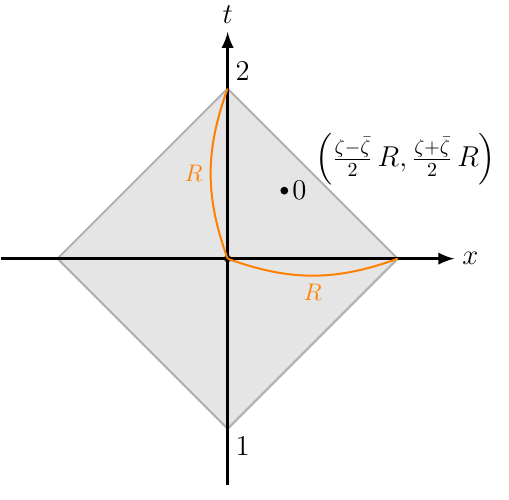
Figure 10 . The causal diamond } 12 corresponding to the con(cid:12)guration (4.27) and (4.28) when d =